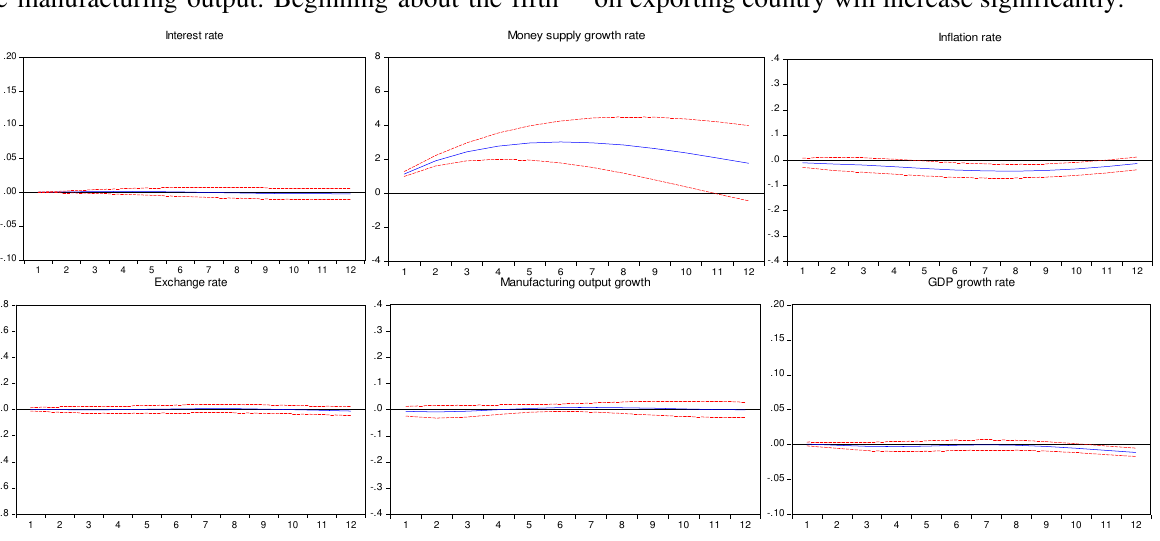
Figure 4. Responses of selected variables to a money supply shock in Algeria